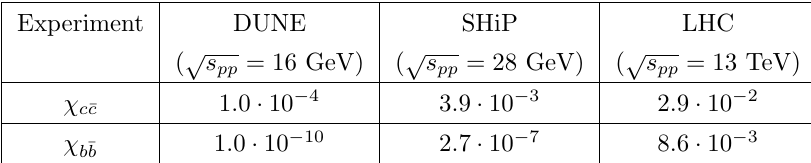
Table 2 . Production fractions of the q (cid:22) q pair, (cid:31) q (cid:22) q = (cid:27) q (cid:22) q =(cid:27) pp , for the DUNE, SHiP and LHC experiments. We took the production fractions for the DUNE and SHiP experiments from [46, 47]. To estimate the production fractions for the LHC, we calculated the total cross section of B and D production using FONLL [48] and took the total cross section of the pp collisions at the LHC energies from [44].